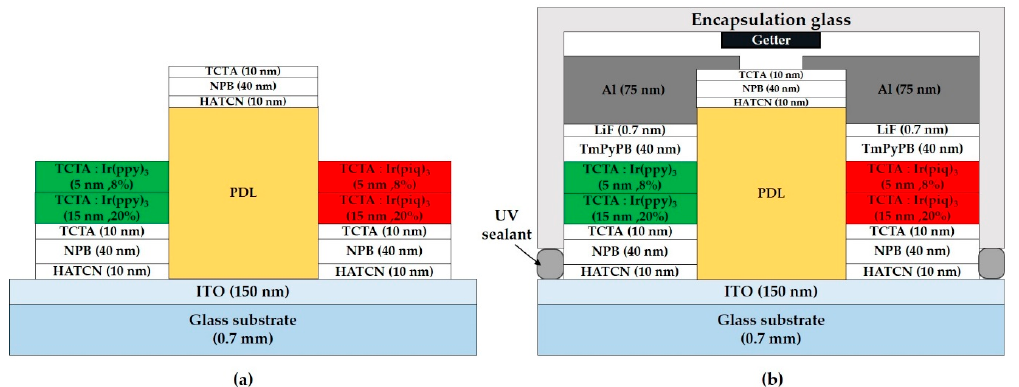
Figure 9. ( a ) Stack structure of green and red patterned EML after second lift-off; ( b ) structure of two-color pixel patterned electroluminescent device.